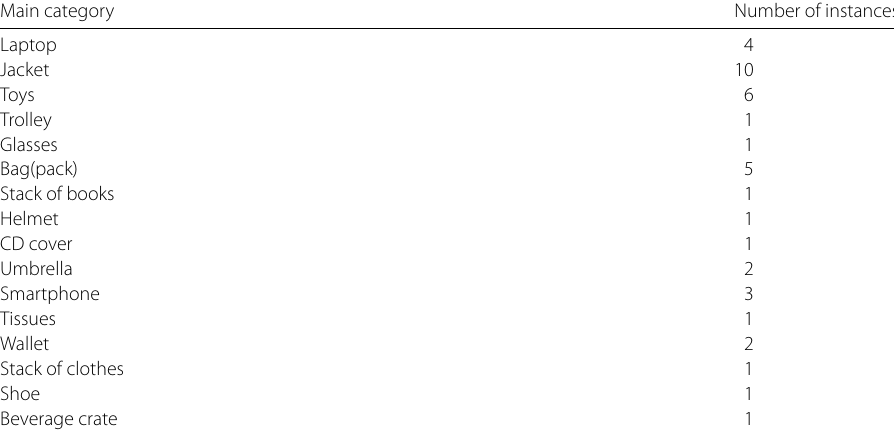
Table 14 Number of instances per main category of the class “Object” in the test set Main category